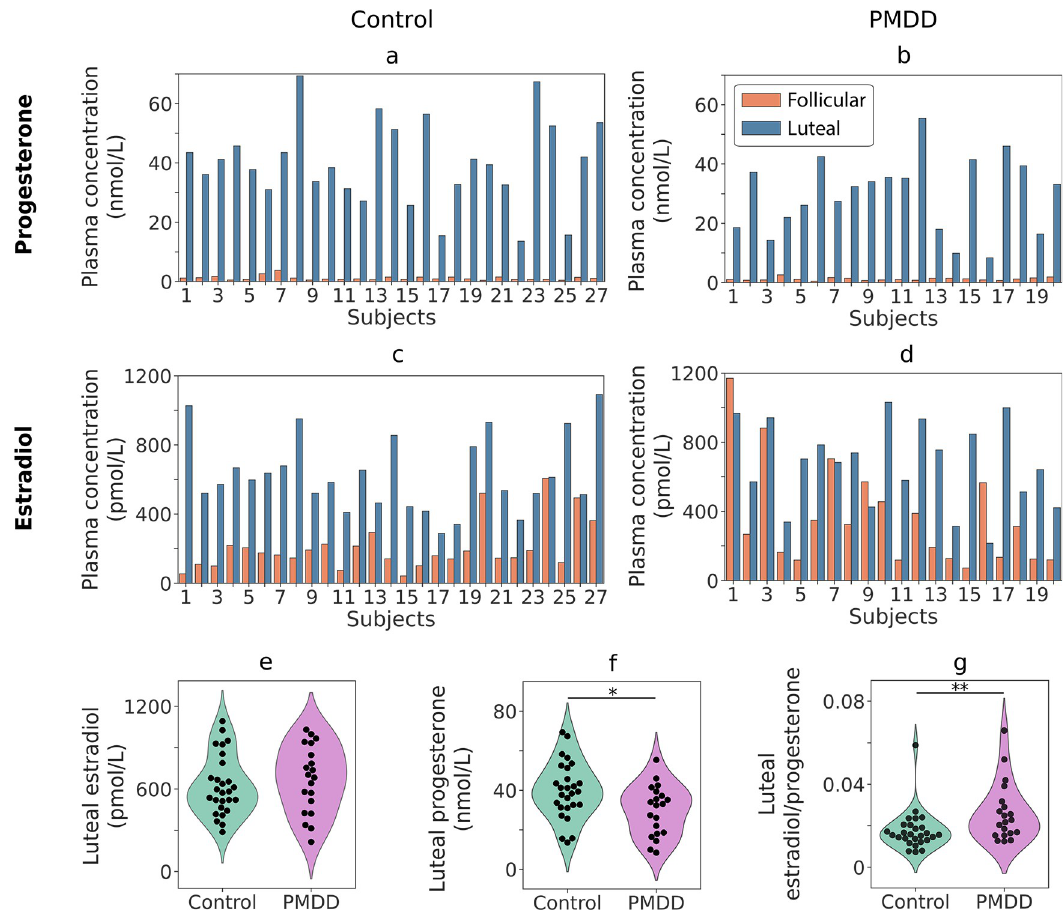
Fig 3. (a-d) Plasma levels of estradiol and progesterone in the control (a, c) and PMDD (b, d) groups in two phases of the menstrual cycle (follicular, luteal). (e-g) Violin plots show estradiol and progesterone concentrations and estradiol to progesterone ratios in the luteal phase of the menstrual cycle in control subjects and subjects with PMDD. � p < 0.05; �� p <